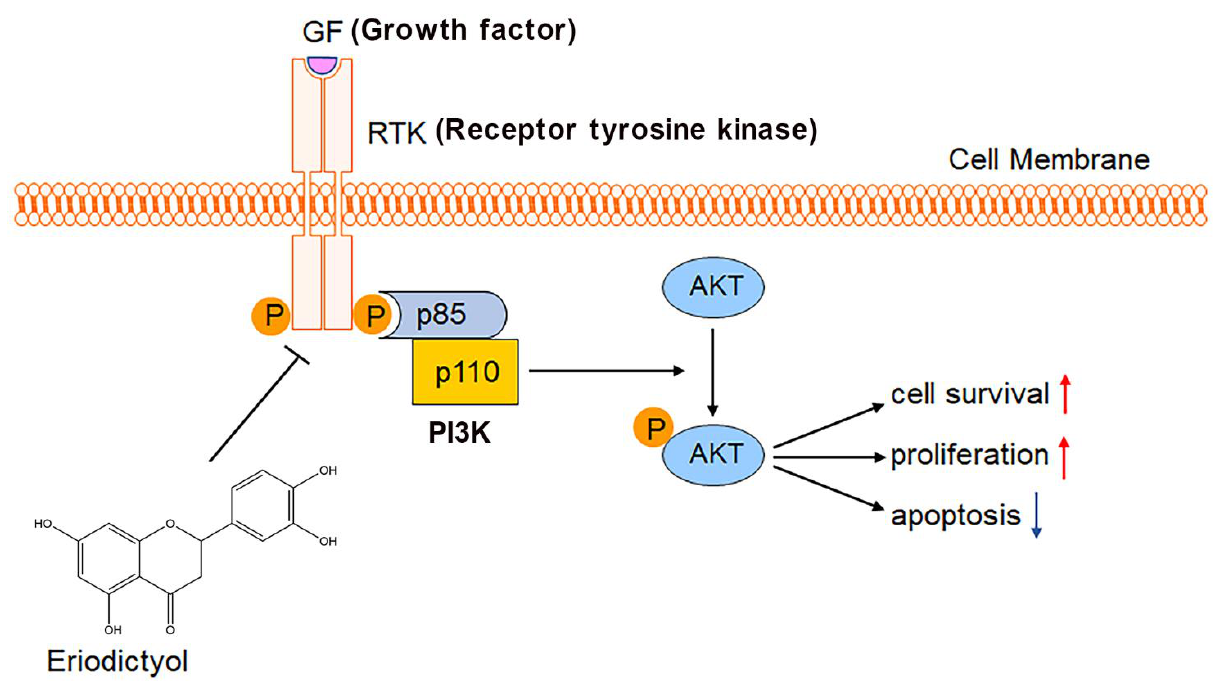
Figure 8. Schematic diagram of the study. Eriodictyol inhibits cell survival and proliferation and induces apoptosis in GC through the PI3K/AKT pathway.